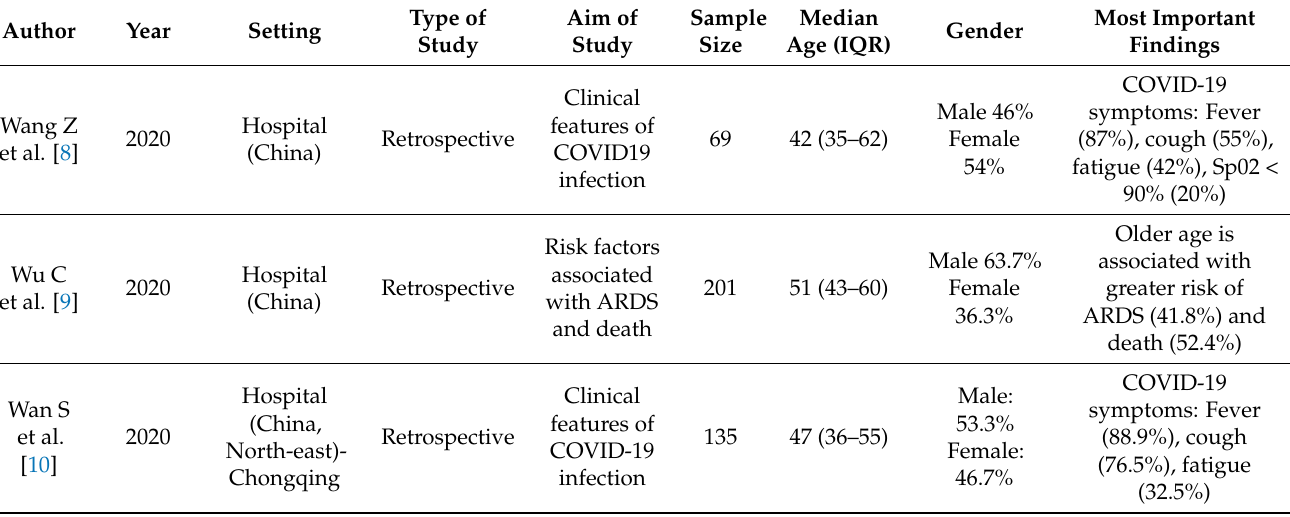
Table 1. The summary of all studies included in this narrative review. Abbreviations used: ARDS = Adult Respiratory Distress Syndrome; CAUTI = Catheter associated urinary tract infec- tions; and PE = Pulmonary